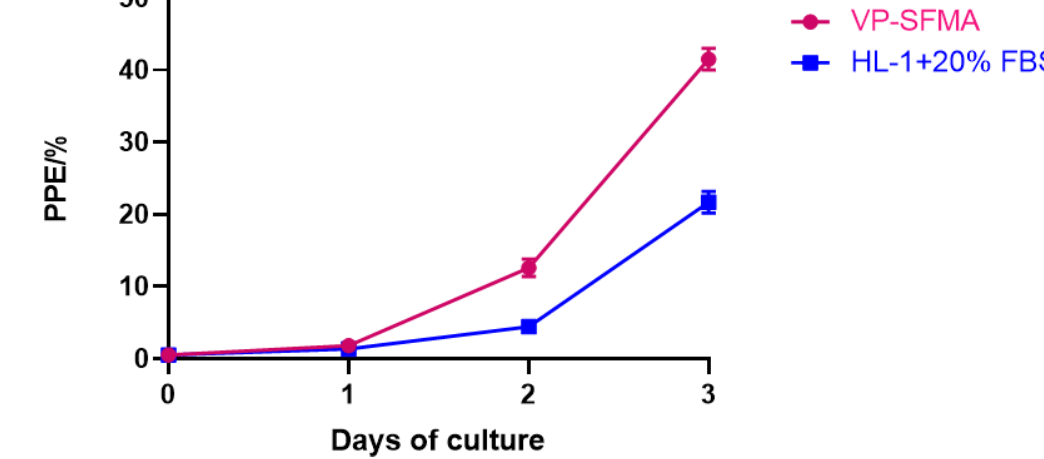
Figure 3. VP-SFMA supports long-term continuous in vitro culture of B. duncani . ( A ) Comparison of the growth curve of B. duncani proliferation using VP-SFMA and VP-SFM +CD LIPID (1:100) medium over a 30-day period with 9 splittings. Mean values from three separate experiments using triplicate wells for each tested condition were represented. PPE: percentage of parasitized erythrocytes. Dotted lines indicate subculturing performed every 3 days and adjusted back to 0.5%. ( B ) Percentages of different parasite development stages in VP-SFMA and 1:100 dilution of CD Lipid mixture. R, ring; DR, double rings; FF, filamentous, T, tetrads. ns: p > 0.05, *: p < 0.05, **: p < 0.01, ***: p < 0.001.